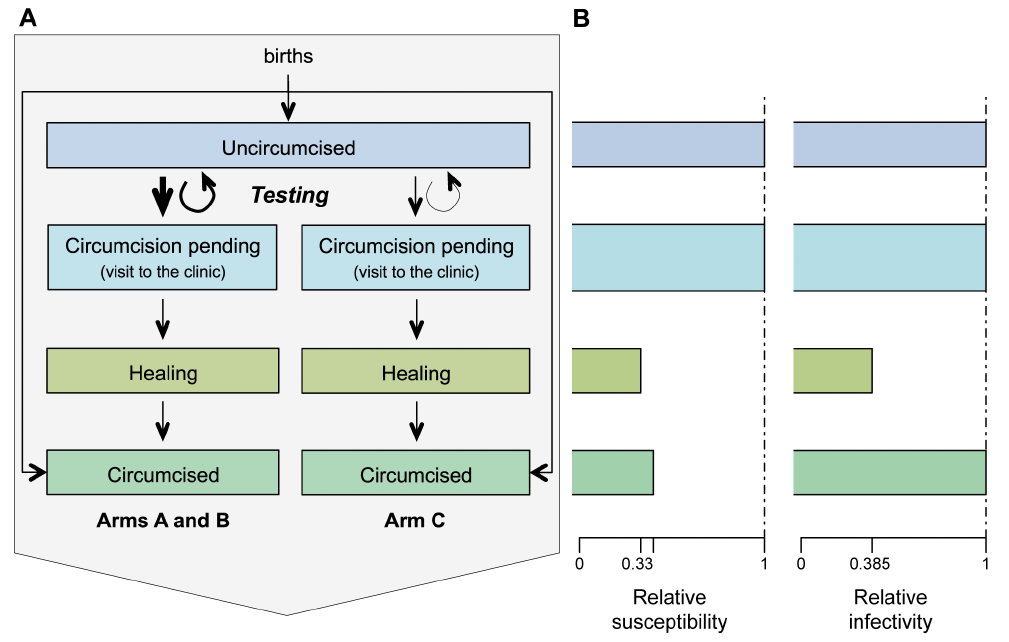
Figure 1. Model structure for susceptible men. A. Flow diagram of the model. Arrows depict the different flow rates between compartments. Men can be circumcised during childhood ( i.e. , before the age of 15). If they are not, they can be circumcised following a negative HIV test. Upon testing, some HIV negative men decide to get circumcised. They then enter a ‘‘waiting’’ stage, which encompasses the time from testing to them actually visiting the clinic for circumcision. After circumcision, they go through a healing period, before being circumcised and healed. B. Relative susceptibility and infectivity in the different stages, relative to an uncircumcised man. Relative susceptibility and infectivity of circumcised men in healing period incorporate both biological increases in susceptibility and infectivity and reduction in sexual activity during the healing period (see main text).